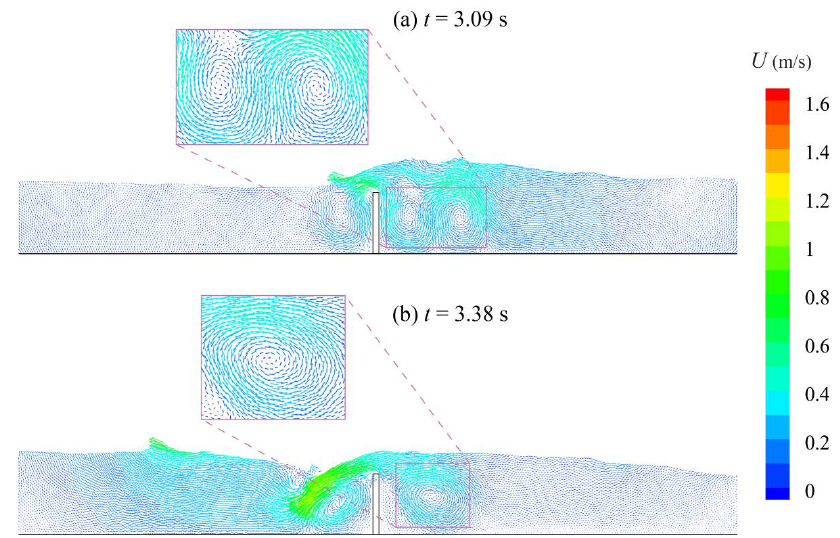
Figure 5. Velocity fields during liquid sloshing with a vertical baffle H B / h 0 = 0.8. ( a ) t = 3.09 s; ( b ) t = 3.38 s. For shallow liquid sloshing, the maximum impact pressure on the border commonly occurs near the free surface. To check the calculation precision of impact pressure, the time history of impact pressure calculated at point A without a baffle is plotted in Figure 6. The experimental result represented by the red dash line is given to verify the numerical result. In addition, the time history of rotational angle of the tank under the excitation is given as well. Overall, the calculated impact pressure by the BM-MPS method coincides with the experimental one very well. Figure 6 reveals that the impact pressure curve has